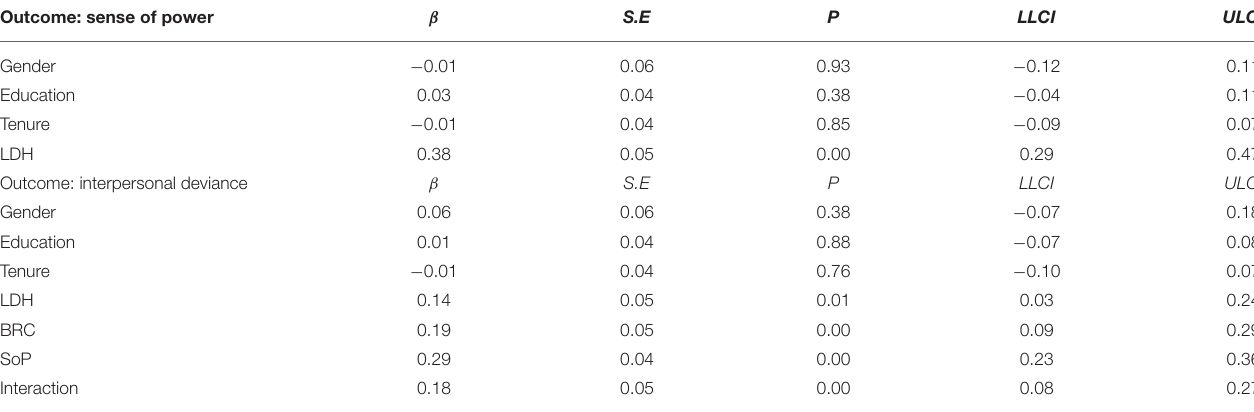
TABLE 3 | Results of the mediated-moderated analyses (PROCESS: model 14). Outcome: sense of power